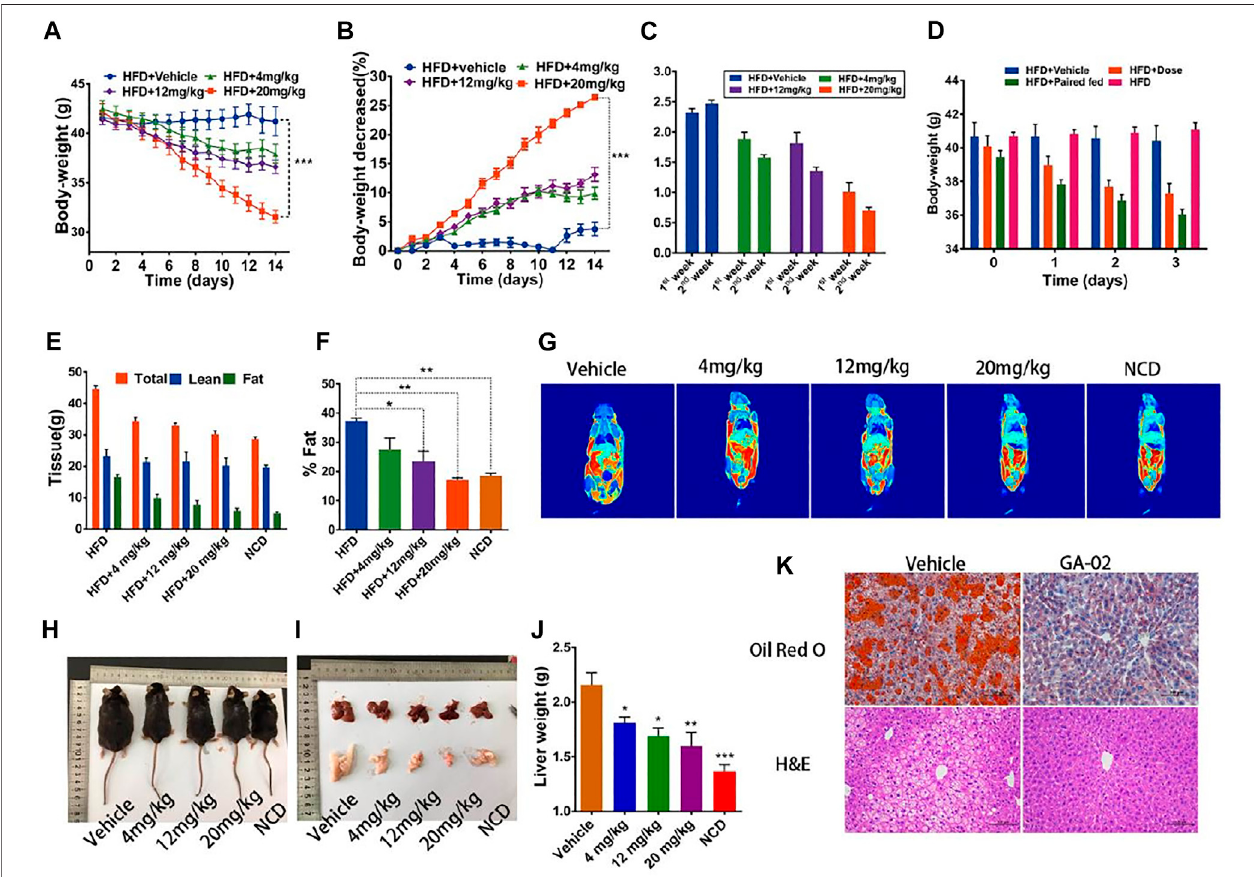
FIGURE3| GA-02reducesthebodyweightofDIOmice.DIOmicereceivedvehicleorGA-02for2 weeks. (A) Thebodyweight, (B) thechangepercentageofbody weight (%), the experiments (A,B) were repeated with two cohorts ( n (cid:2) 6 for each group). (C) The daily food intake in the fi rst and second week for each group. (D) The body weight changes in the fi rst 3 days. (E) The total tissue weight and deduced lean mass and (F) fat mass by MRI after a 2-weeks treatment ( n (cid:2) 3 for each group), which was repeated in two cohorts. (G) Representative MRI imaging of in vivo mice fat. (H) The representative images of each dose group after a 2-weeks treatment. (I) TherepresentativeimagesLiverandepididymalfatpad. (J) Liverandweightforeachtreatedgroup( n (cid:2) 4forvehiclegroup; n (cid:2) 3foreachGA-02group); (K) The H&E and Oil Red O staining of liver sections after high dose of GA-02 treatment.Scale bar, 100 µm (* p < 0.05, ** p < 0.01, *** p <